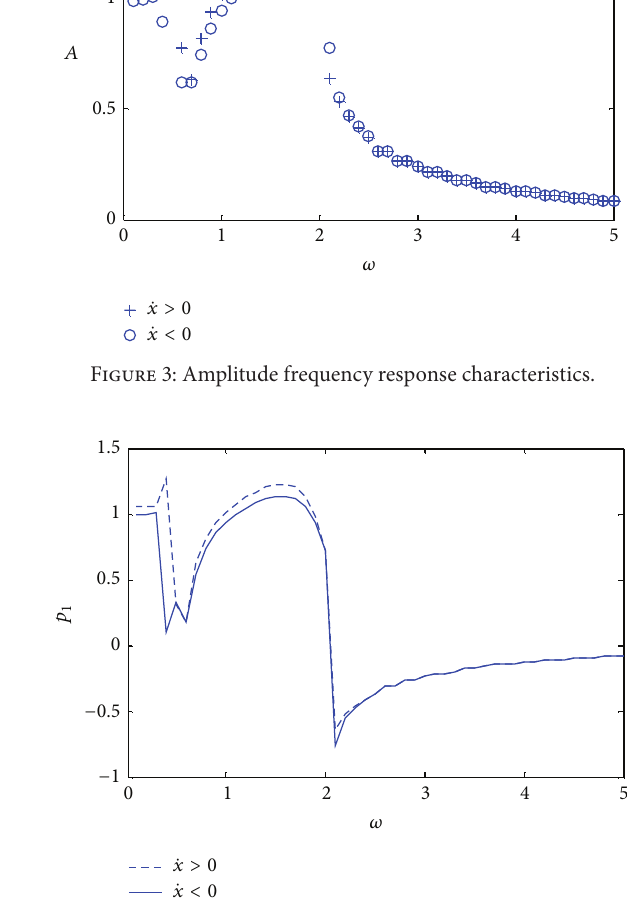
Figure 4: Relationship between 𝑝 1 and 𝜔